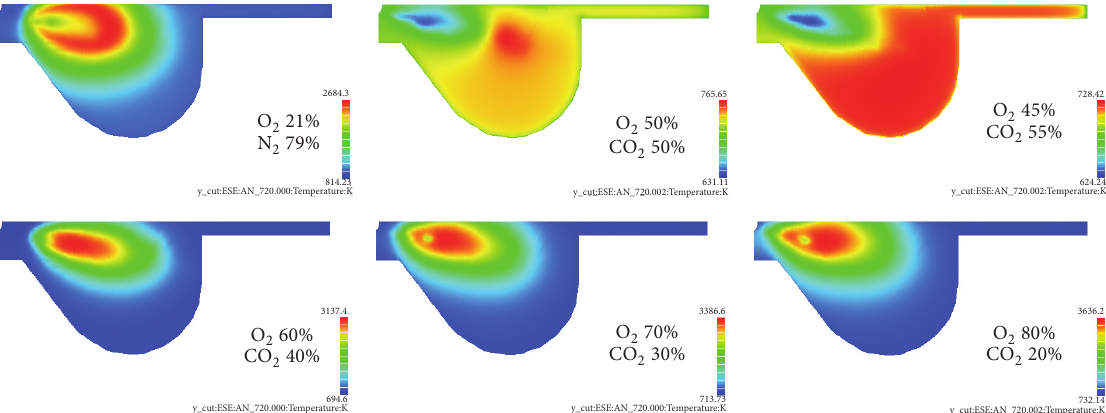
Figure 9: Temperature distribution of the engine’s cylinder at top dead center positions in the environment of different high O 2 volume fraction.